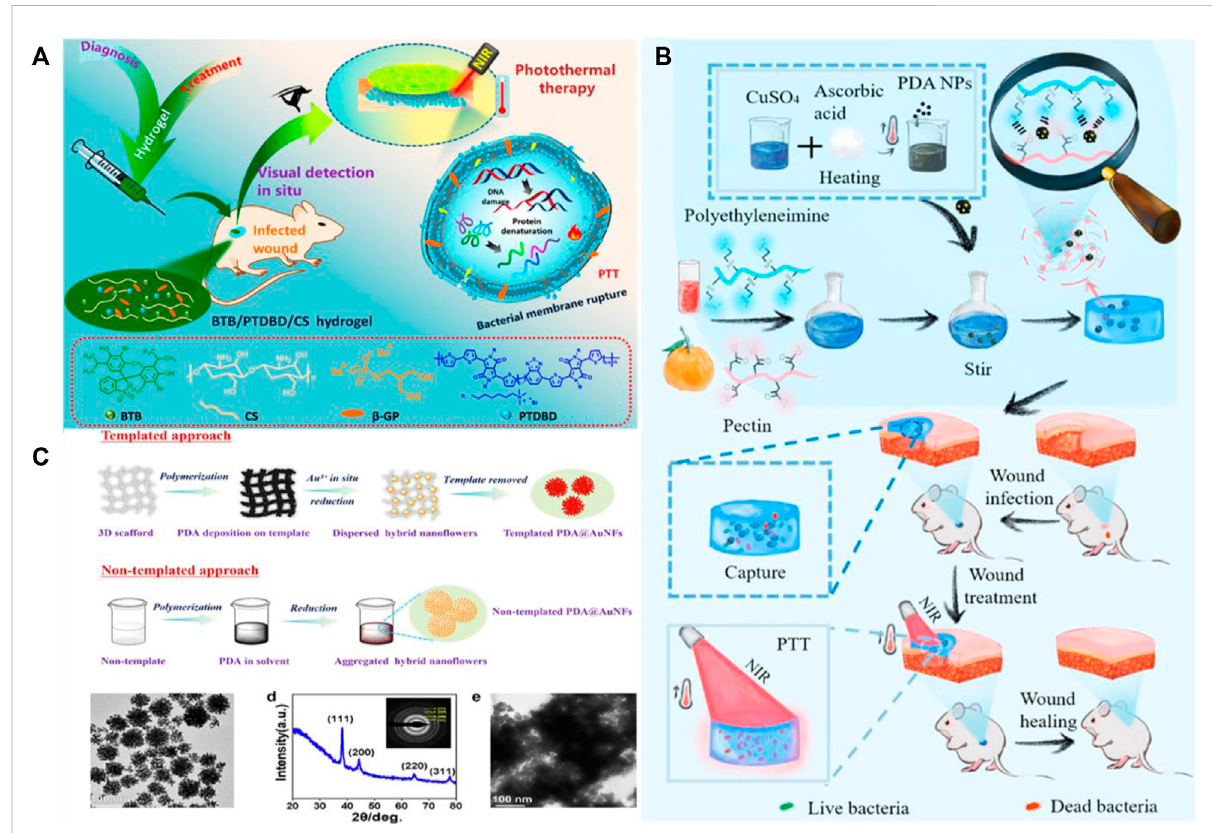
FIGURE 10 (A) Preparation of thermosensitive chitosan hydrogel and its application in the diagnosis and photothermal treatment of bacterial infection. Reproduced from ref. 78 with permission from 2020, American Chemical Society. (B) Synthesis and antimicrobial representation of CPAP/PDA@Cu hydrogels. Reproduced from ref. 41 with permission from 2022 The Authors. Published by Elsevier Ltd. (C) Preparation diagram and performance characterization of PDA@AuNFs. Reproduced from ref. 30 with permission from 2022 Elsevier